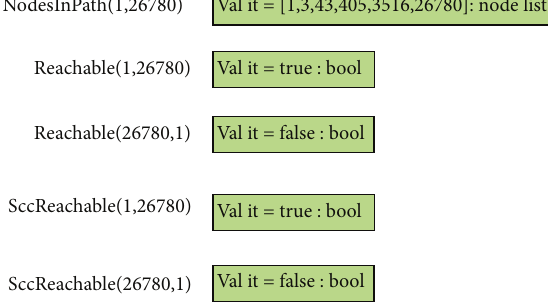
Figure 7: Occurrence sequence marking 𝑀 1 to 𝑀 26780 .